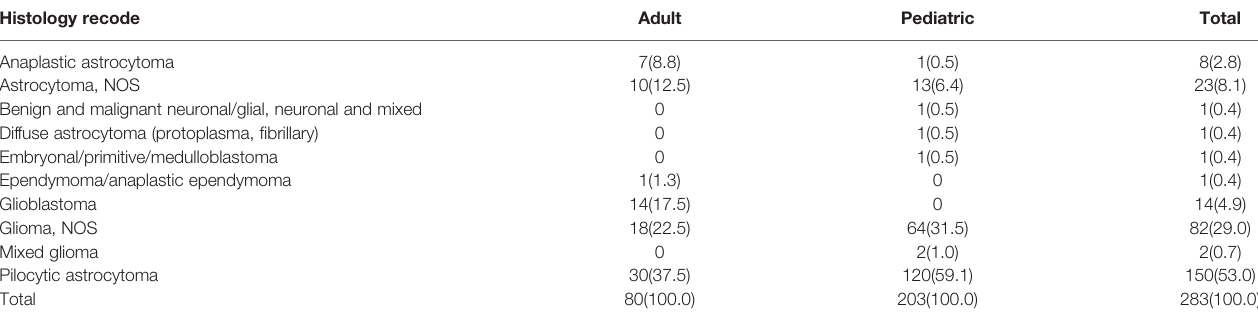
TABLE 3 | The distribution of the patients with histology